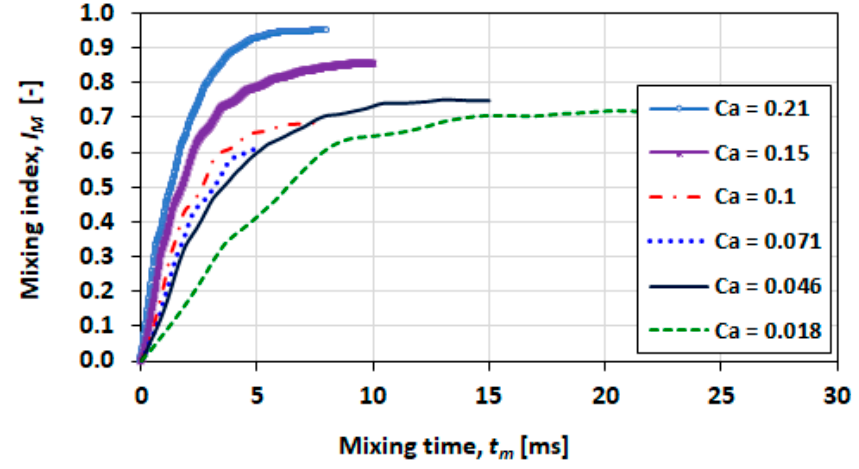
Figure 27. Mixing performance at various capillary numbers for λ = 0.5. Contours of concentration at various times for Ca = 0.21 and λ = 0.5 are shown in Figures 28 and 29 for Ca = 0.21 and λ = 2, respectively. The latter case exhibits slower mixing due to the higher viscosity of the fluid in the droplet.